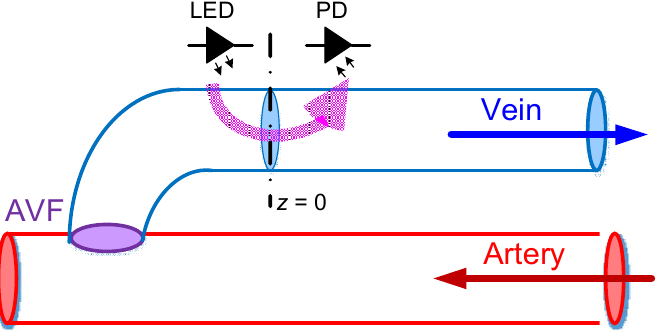
Figure 2. The coordinate axis used in this work, where the z -axis lies along the blood vessel with the measuring spot assumed to be at z = 0.